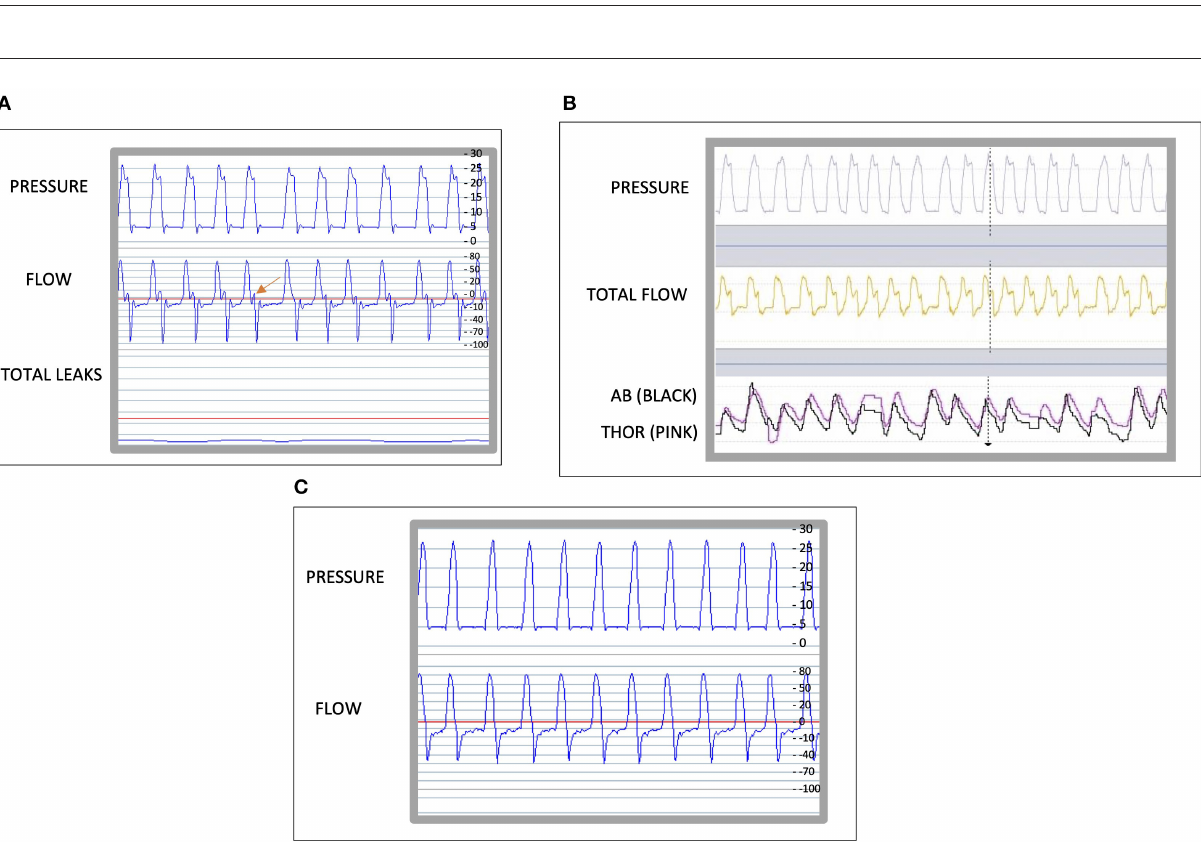
FIGURE3 (A) , Shows a 1min epoc of the traces of a Lumis 150 ventilator (Resmed, San Diego, CA, USA) using Rescan program (ResMed, Lyon, France). The leak is close to 0l/mn. The arrow indicates the asynchrony. (B) Shows a 1min epoc of the traces on a Breas TM PC software showing the abdominal [AB (black)] belt and thoracic belt [THOR (pink)], the dotted vertical line shows a late cycling. (C) shows a 1min epoc of the traces of a Resmed TM ventilator using Rescan